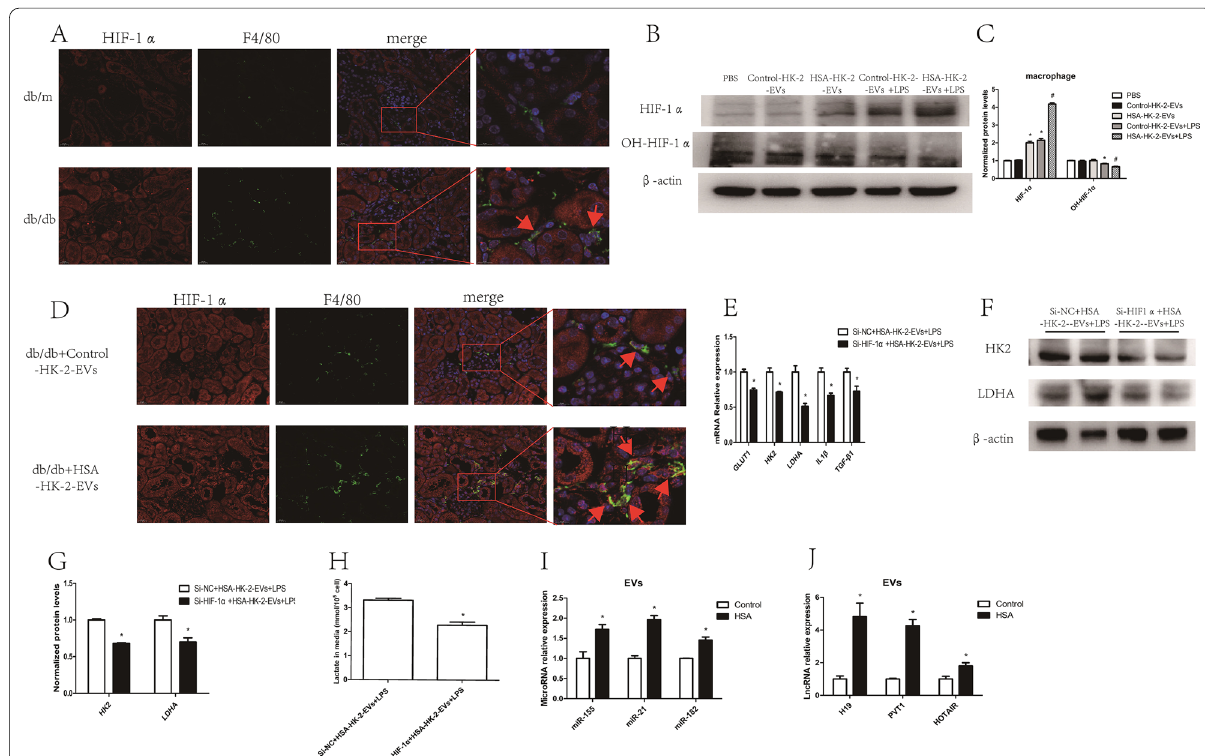
Fig. 6 HSA-treated tubular epithelial cell-derived EVs promoted macrophage glycolysis by stabilizing HIF-1α. A Double IHC staining of HIF-1α (red) and F4/80 (green) in the kidney cortexes of db/m and db/db mice. Macrophages were co-cultured with tubular epithelial cell-derived EVs: B , C protein level of HIF-1α and extent of HIF-1α hydroxylation (n 3); * p < 0.05 vs. the Control-HK-2-EVs group; # p < 0.05 vs. the = Control-HK-2-EVs LPS group; D double IHC staining of HIF-1α (red) and F4/80 (green) in the kidney cortexes of db/db Control-HK-2-EVs and db/ + + db HSA-HK-2-EVs mice. Macrophages transfected with HIF-1α siRNA and co-cultured with HSA-HK-2-EVs: E mRNA levels of GLUT1, HK2, LDHA, + IL1β and TGF-β1 (n 3); F , G protein levels of HK2 and LDHA (n 4); H amount of lactate in the macrophage supernatant (n 3); * p < 0.05 vs. the = = = Si-NC HSA-HK-2-EVs LPS group. MiRNAs and lncRNAs that have been reported to modulate HIF-1α expression were measured in EVs. * p < 0.05 + + vs. the Control-HK-2-EVs group (n =